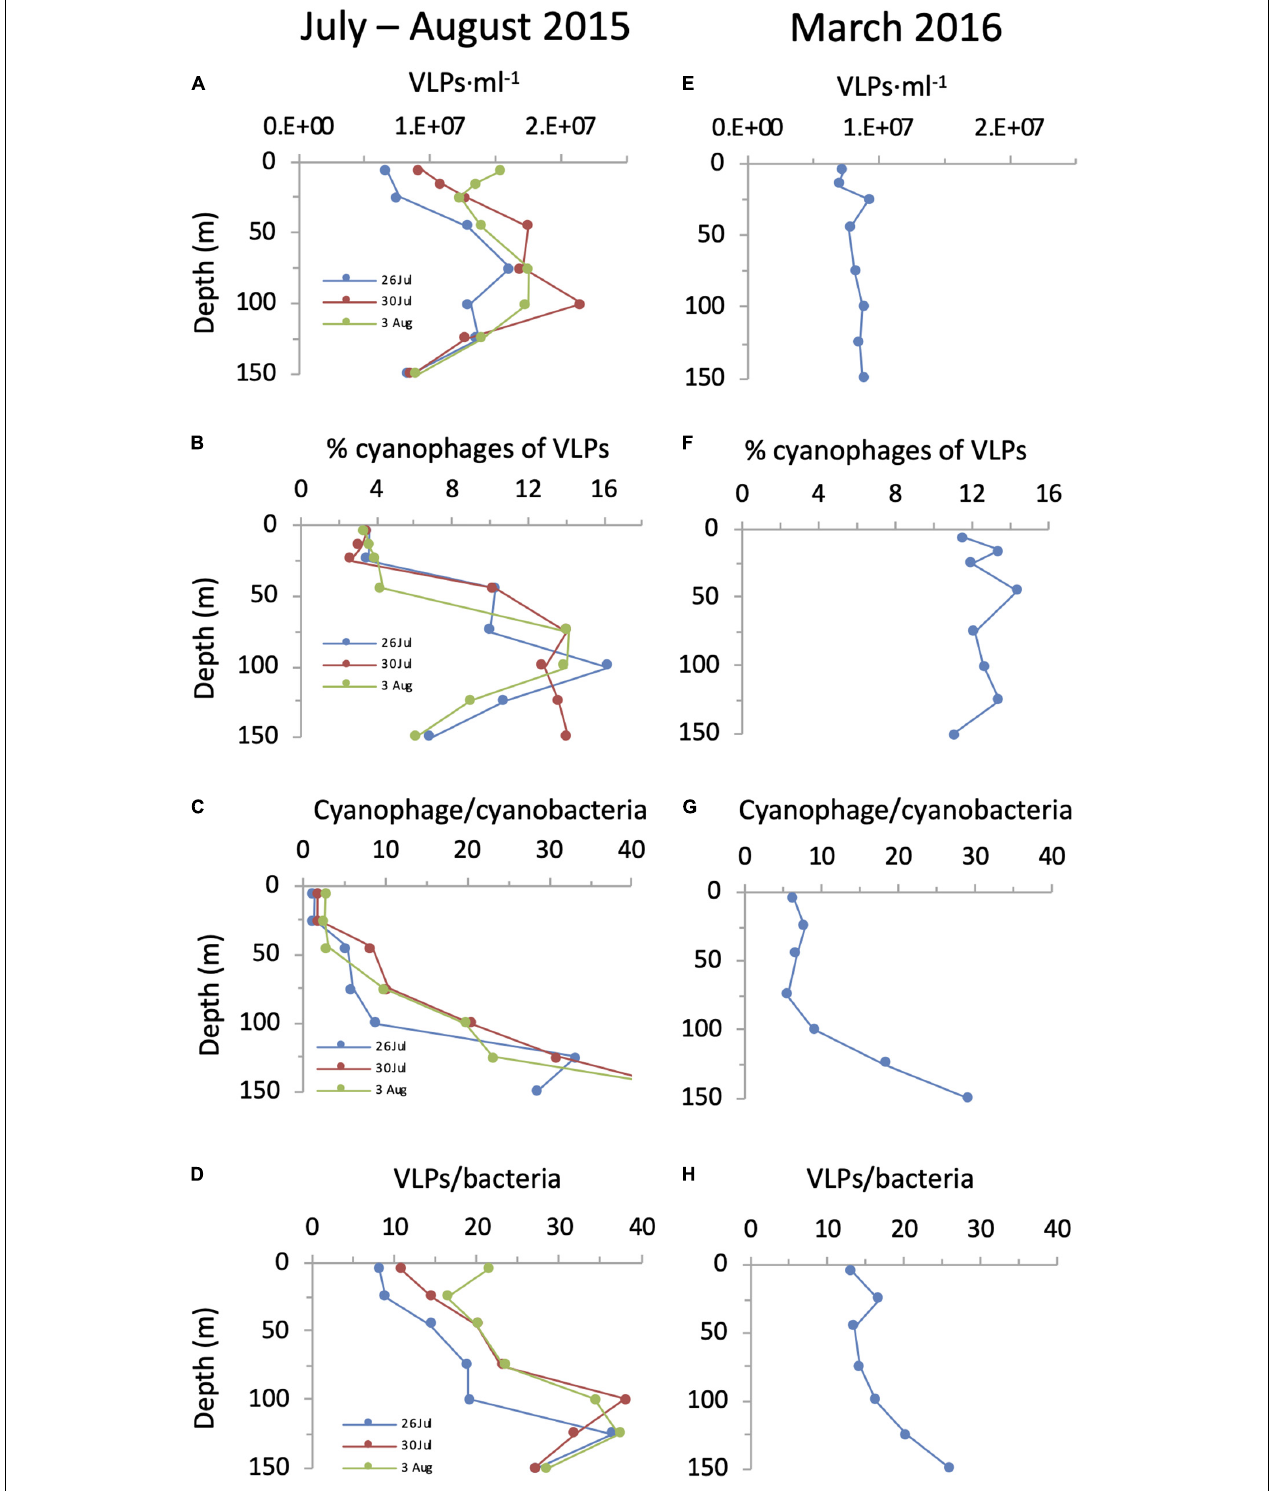
FIGURE 8 | Cyanophage abundances in relation to VLPs and cyanobacteria over depth profiles in the NPSG. Abundances of VLPs (A,E) , percent cyanophages of VLPs (B,F) , the ratio of cyanophages to cyanobacteria (C,G) and the ratio of VLPs to total bacteria (D,H) during the summer cruise in July–August 2015 (left panels) and in the spring cruise in March 2016 (right panels). For these analyses, we are assuming that the vast majority of VLPs are dsDNA-containing viruses and that the majority of cyanophages in the NPSG are T4-like and T7-like cyanophages quantified by the polony method.